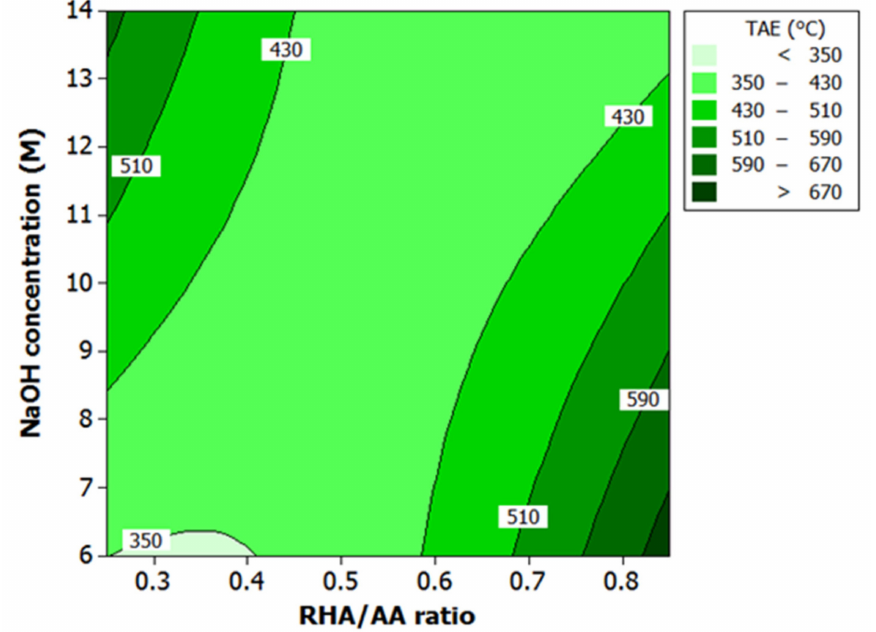
Figure 7. Contour plot for the effect of RHA/AA ratio and NaOH concentration on the TAE in fire-retardant test.